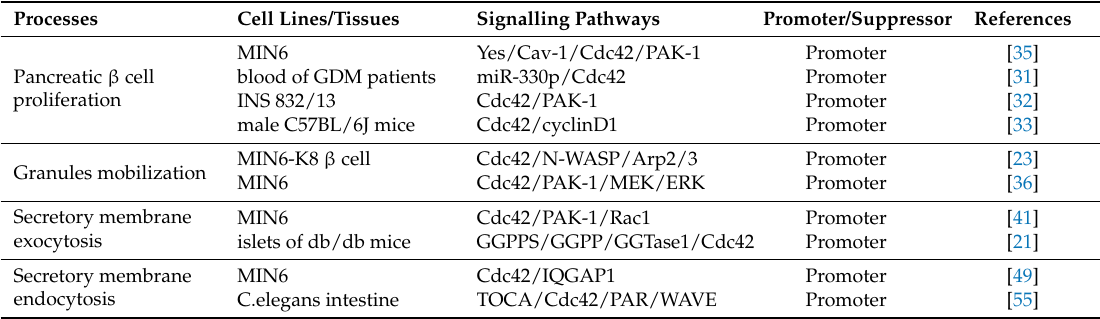
Table 1. Cdc42 and insulin